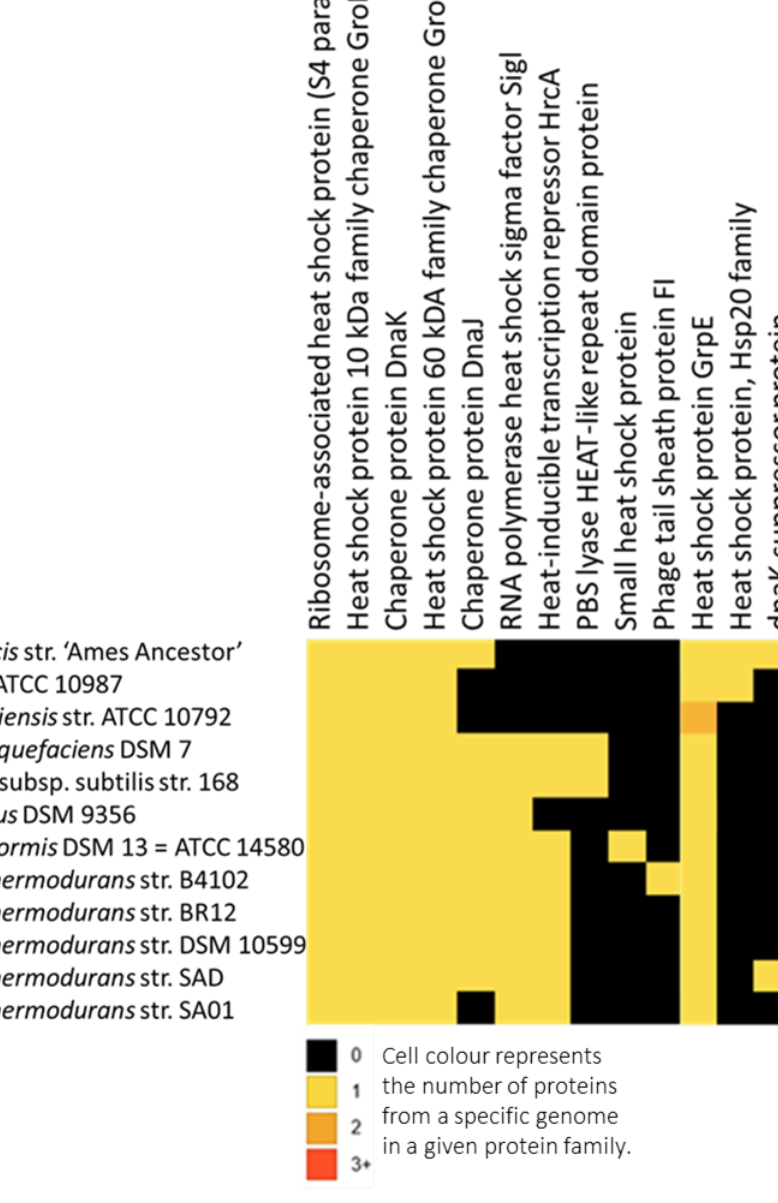
Figure 4. Heat map of genomes of Bacillus species and associated protein clusters responsible for heat resistance. The heat map was inferred using the PATRIC protein families’ utility and clustered by genomes using Pearson’s correlation and pairwise average linkage. Cell color represents the number of proteins from a specific genome in each protein family.